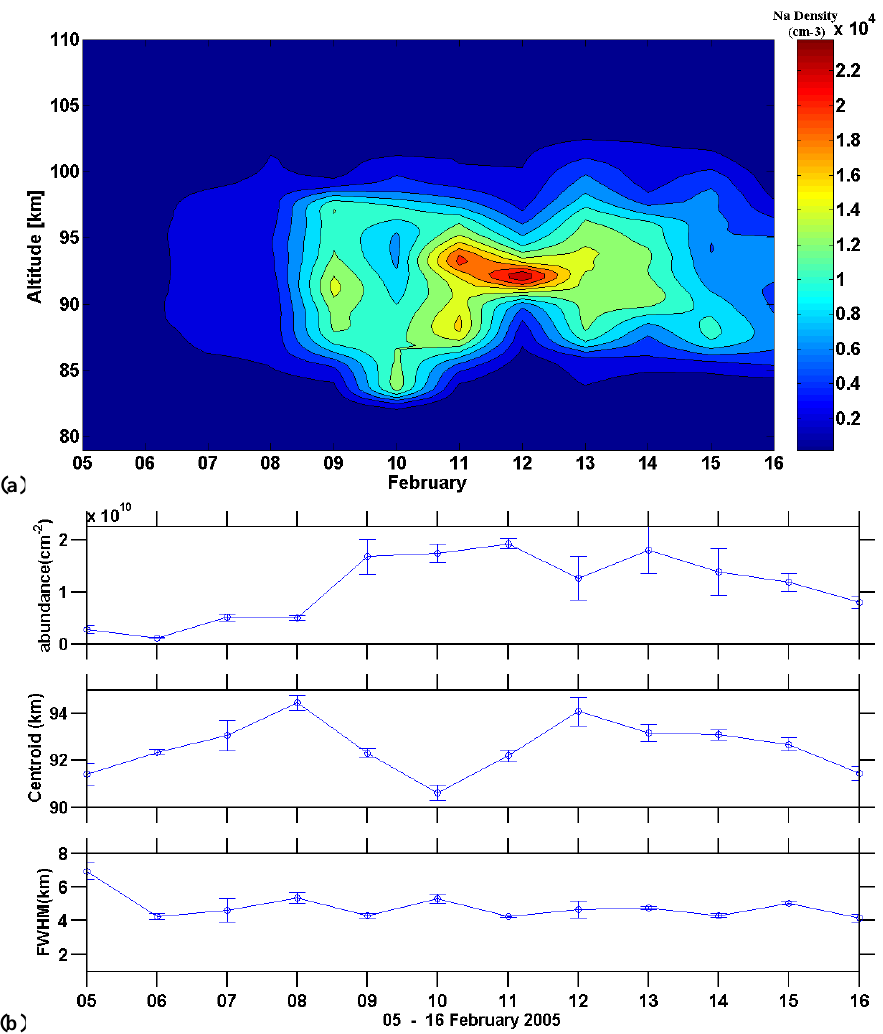
Fig. 3. (a) Contour plots of the averaged Na density (cm − 3 ) for the period from 5–16 February 2005. (b) Day-to-day variations of Na abundance, centroid and RMS width obtained during the above said period (5–16 February 2005) over Gadanki by